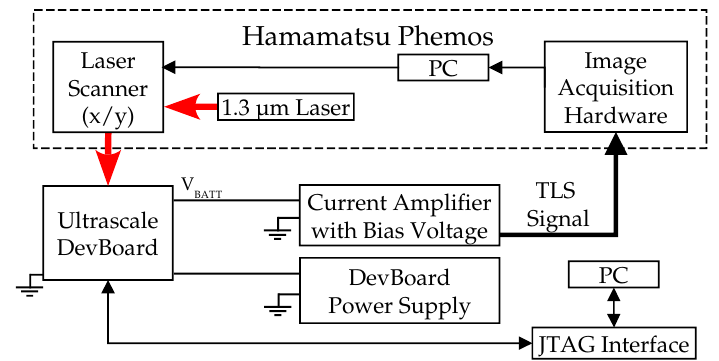
Figure 6: Block diagram of the setup used for laser